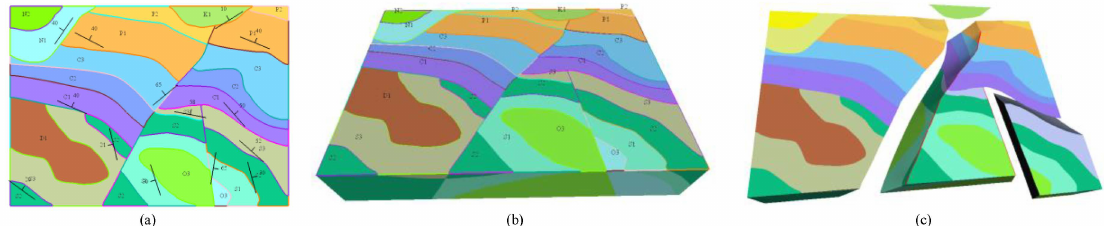
Figure 11. Fault models from a geological map: ( a ) 2D geological map containing two faults; ( b ) 3D geological model; and ( c ) exploded view of the geological model divided by the